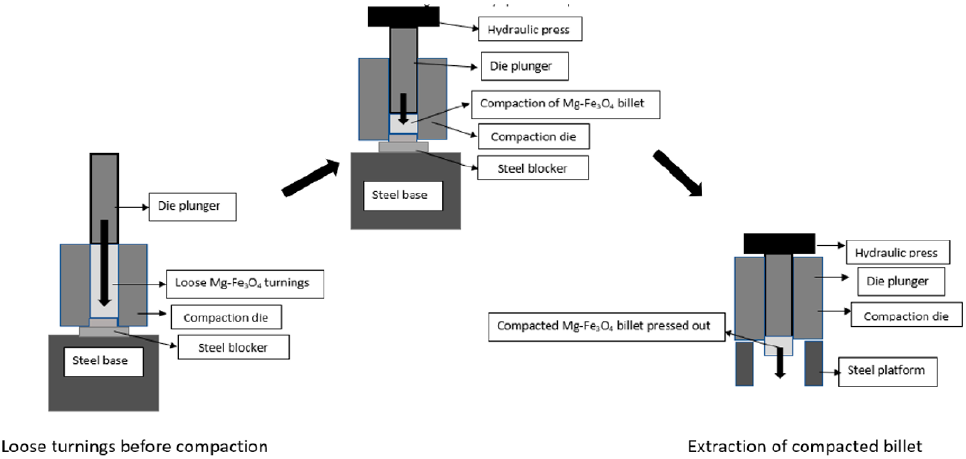
Figure 3. Schematic of turning compaction into TID billets[24].